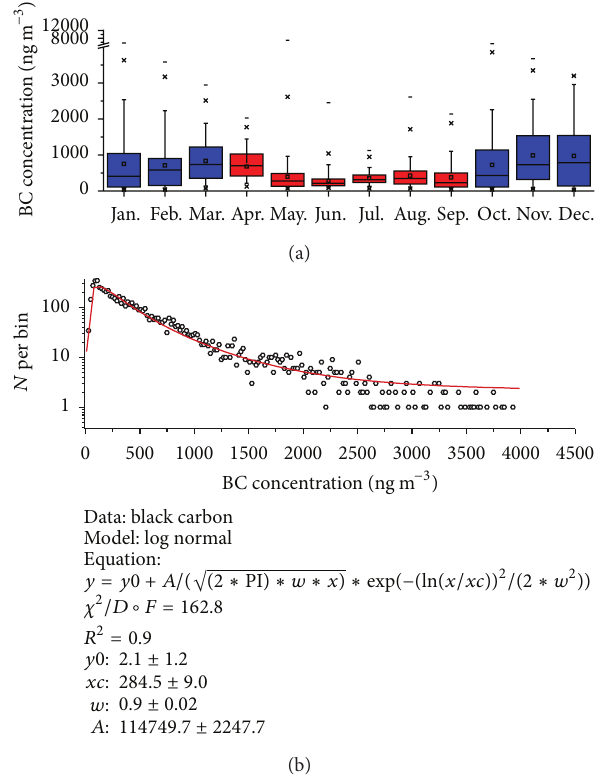
Figure 1: (a) Box and whisker plots for comparison of mass concen- trations at Preila; (b) BC concentration frequency